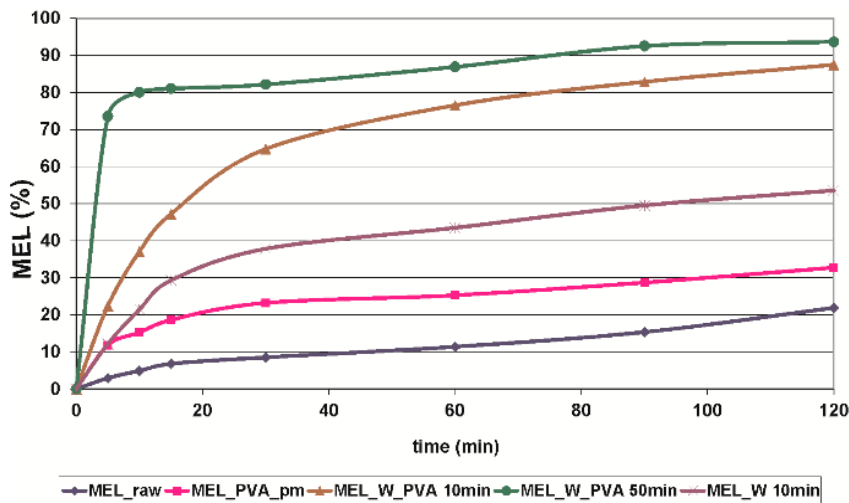
Figure 5. In vitro dissolution profile of MEL_raw, MEL_PVA_pm, MEL_W 10 min, MEL_W_PVA 10 min and MEL_W_PVA 50 min (SD < 0.05%).